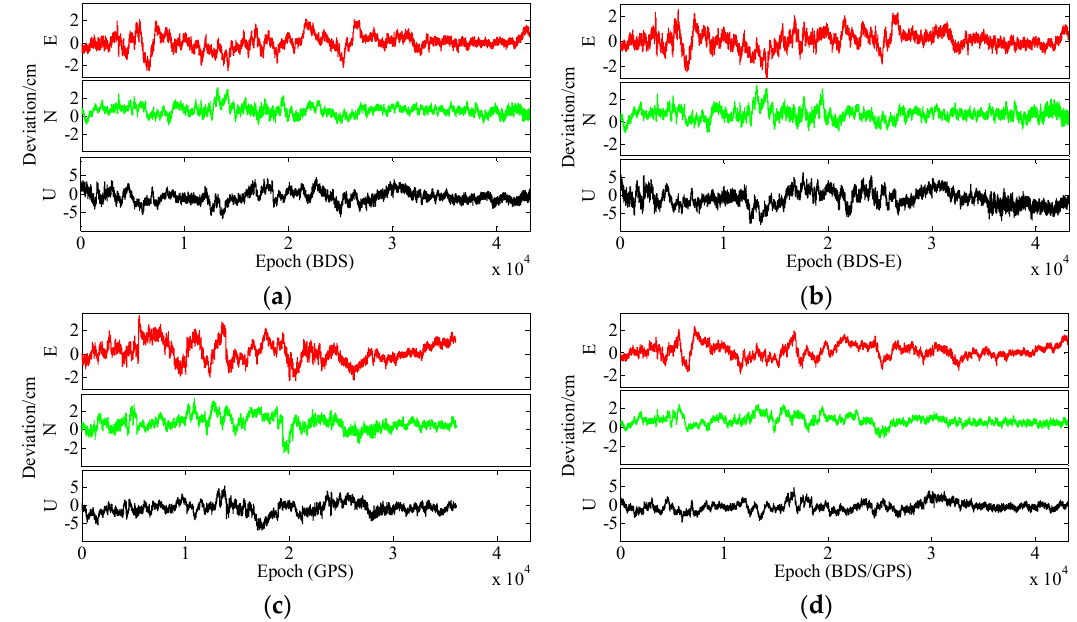
Figure 13. ENU deviations of four systems for group A. ( a ) ENU deviations of BDS for group A. ( b ) ENU deviations of BDS-E for group A. ( c ) ENU deviations of GPS for group A. ( d ) ENU deviations of BDS/GPS for group A.